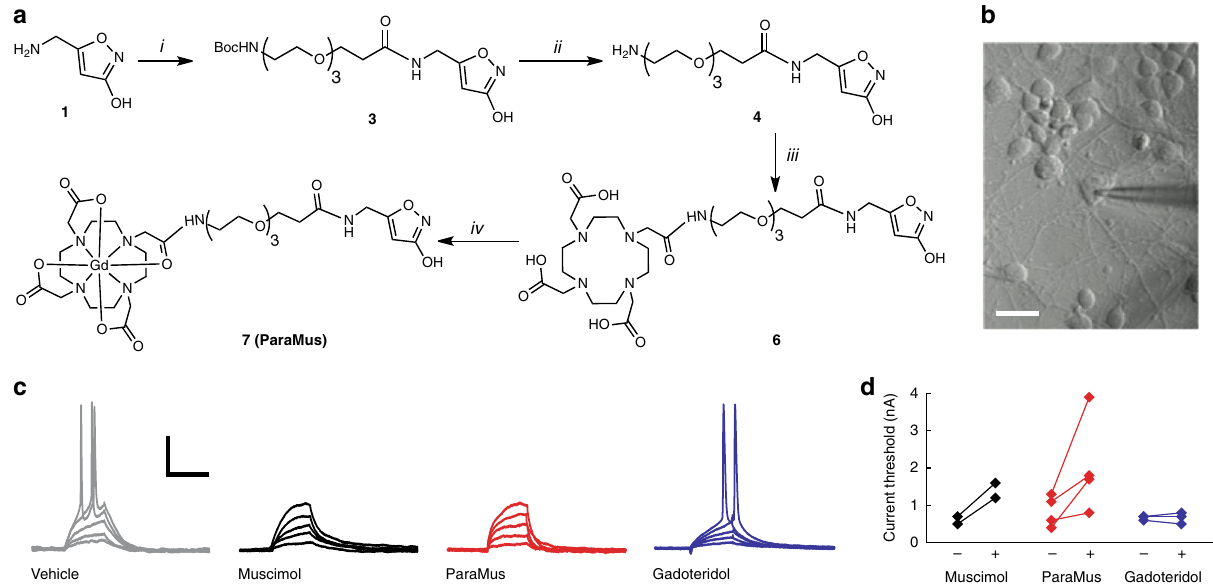
Fig. 1 Synthesis and pharmacological characterization of ParaMus. a Chemical synthesis of ParaMus ( 7 ): (i) HOOC-PEG3-NHBoc, EDC/NHS, MOPS (100 mM, pH 5.5), (ii) TFA/DCM (80:20), (iii) DOTA-NHS, MOPS (25 mM, KCl 100 mM, pH 8), (iv) GdCl 3 , H 2 O, pH 5.5. b Setup for intracellular recording of primary rat cortical neurons (scale bar = 10 µ m). c Representative current-clamp recordings in response to injection of 0.1-0.5 nA current injection in the presence of vehicle, 10 µ M muscimol, 10 µ M ParaMus, and 10 µ M gadoteridol. Scale bars, horizontal = 20 ms, vertical = 10 mV. d Current thresholds for action potential generation before ( − ) and after ( + ) application of muscimol, ParaMus, or gadoteridol. Paired measurements are shown for two (muscimol), four (ParaMus), or three (gadoteridol) independent